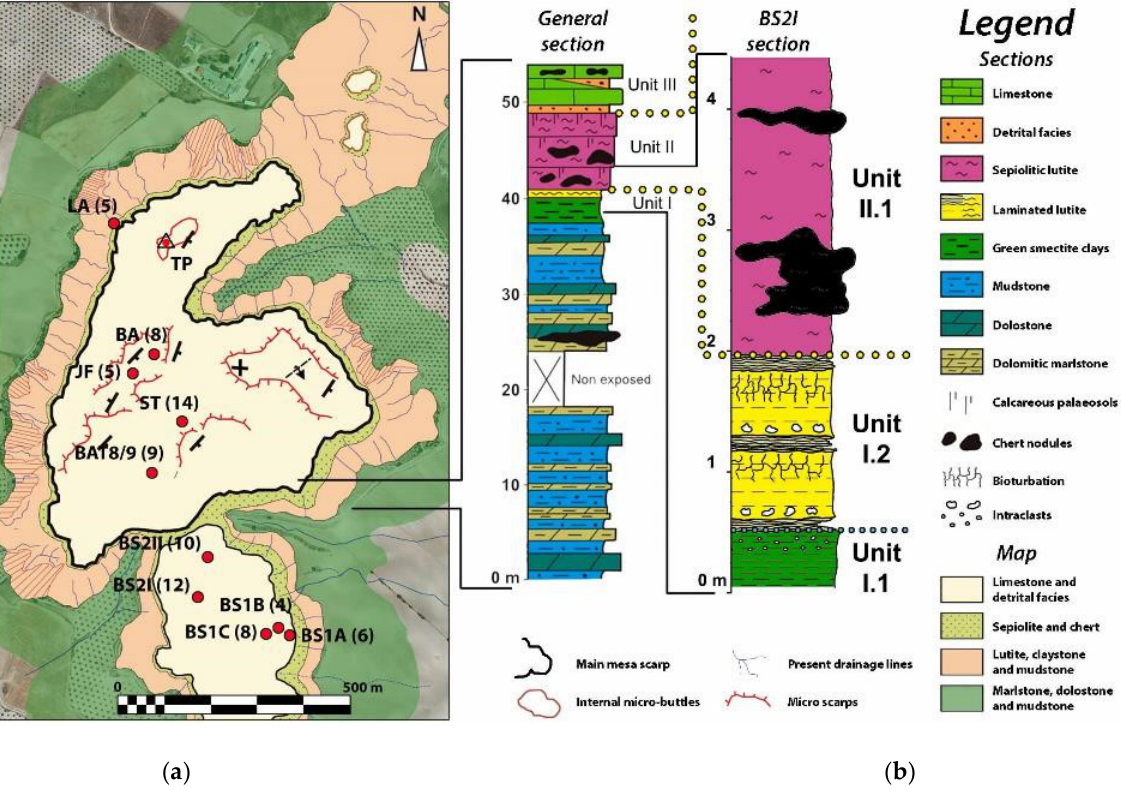
Figure 2. ( a ) Geological sketch of Cerro de los Batallones showing the location of the study lithological sections; and ( b ) log showing the general lithostratigraphy of the Cerro de los Batallones and detail of the differentiated